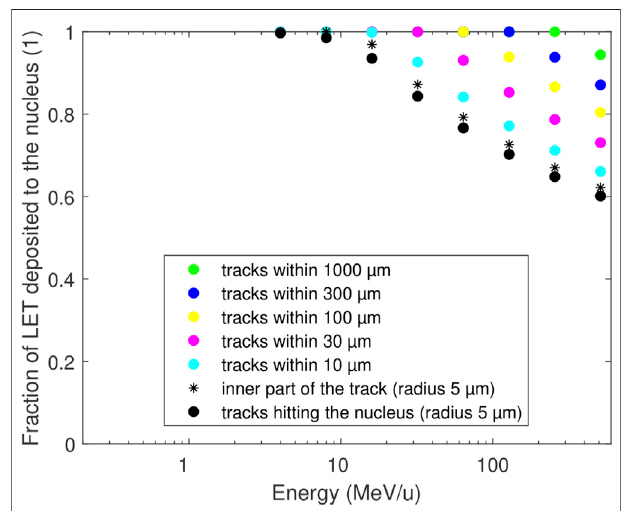
FIGURE 5 | Energy deposited to a cell nucleus when only tracks are considered that directly hit the nucleus with their cores (black circles) as in the present track-structure simulations, or including the contribution from all tracks within a larger region (coloured symbols) at a given fl uence. The depositedenergy isexpressed asthefraction oftheparticle LET(linearenergy transfer). The mean deposit per track directly hitting the nucleus (black circles) can be approximated by the energy deposit by the inner part of the track with thesamesize, Eq.4 (blackstars).Calculationsbasedontheamorphoustrack structure